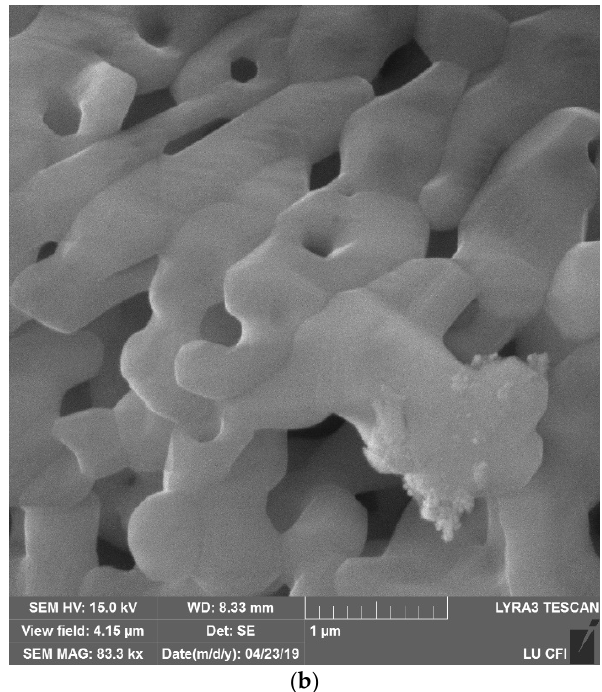
Figure 3. SEM results. ( a ) One microparticle. ( b ) The same particle with a higher zoom; the traces of nanoparticles can be observed.